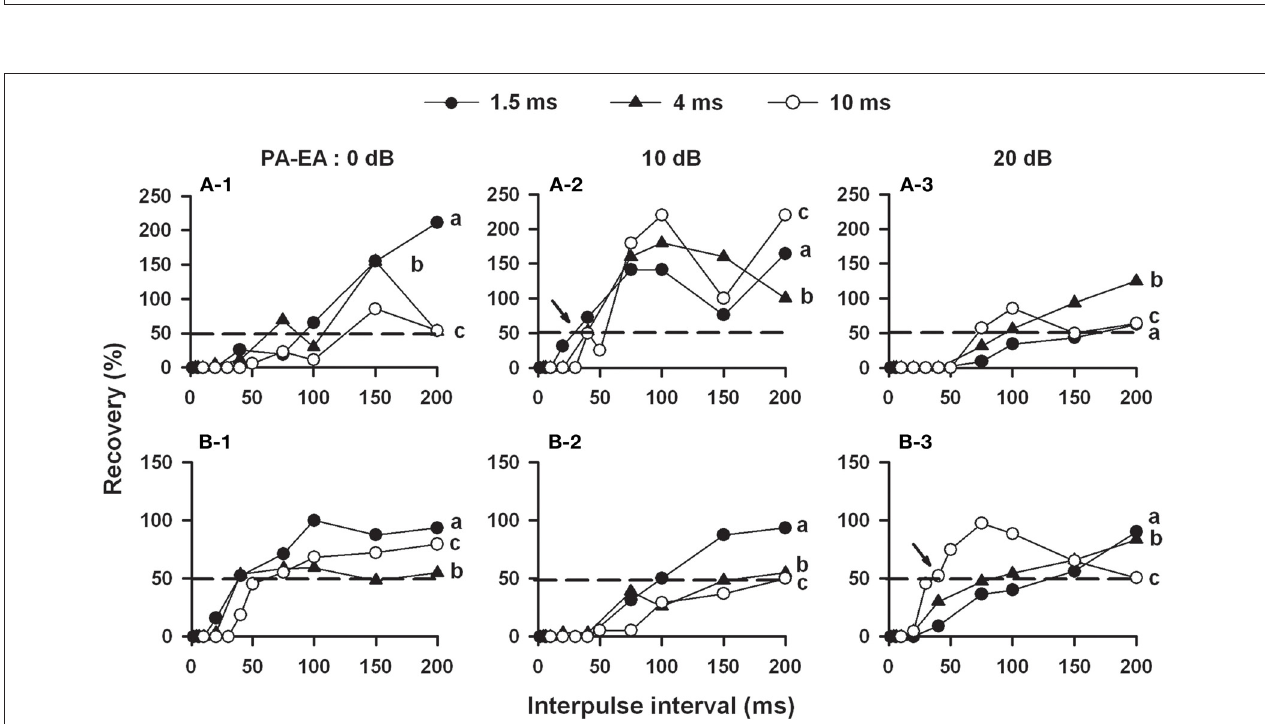
( Ab , Bb ) The distribution of percent change in nDW in relation to the recording depth. The linear regression line and correlation coefficient for each plot are shown by a solid line and r [From Jen and Wu (2006)].